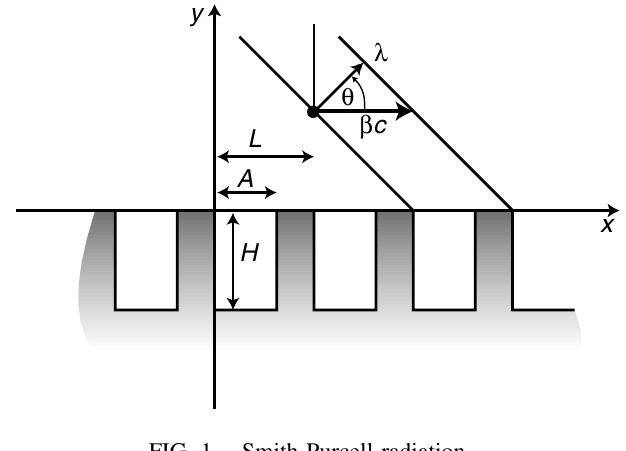
FIG. 1. Smith-Purcell radiation. Fig. 1 [17]. The virtual photons of the electron field are scattered by the grating, and the wavelength (cid:6) radiation observed at the angle (cid:9) from the direction of the electron beam is